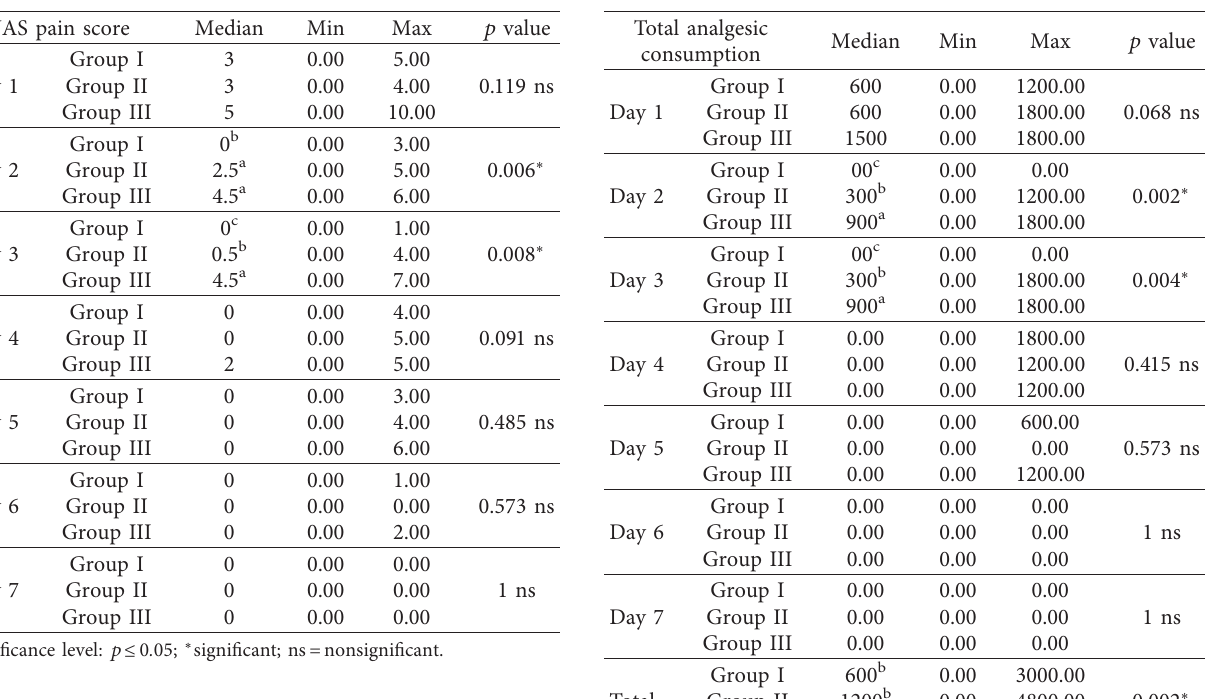
Figure 3: CONSORT flow diagram. Table 1: Median and range values for intergroup comparison of Table 2: Median and range values for intergroup comparison of postoperative pain measured by the VAS score daily from day 1 to postoperative pain measured by analgesic consumption (mg) daily day 7 in the three groups. from day 1 to day 7 in the three